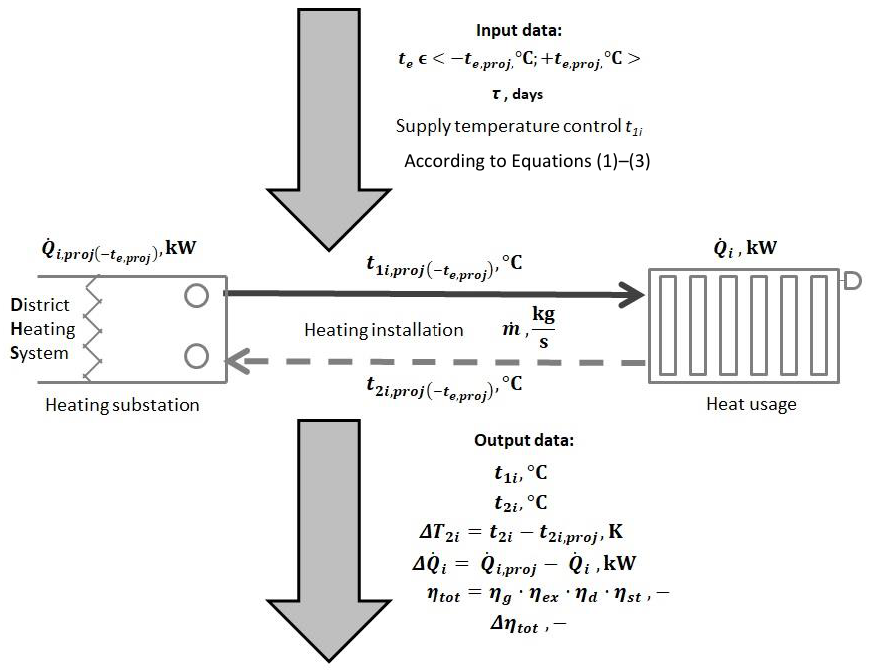
Figure 2. Scheme of input data for the selection of a dispersed PCM heat accumulator for cooperation with a DHS and the expected results .